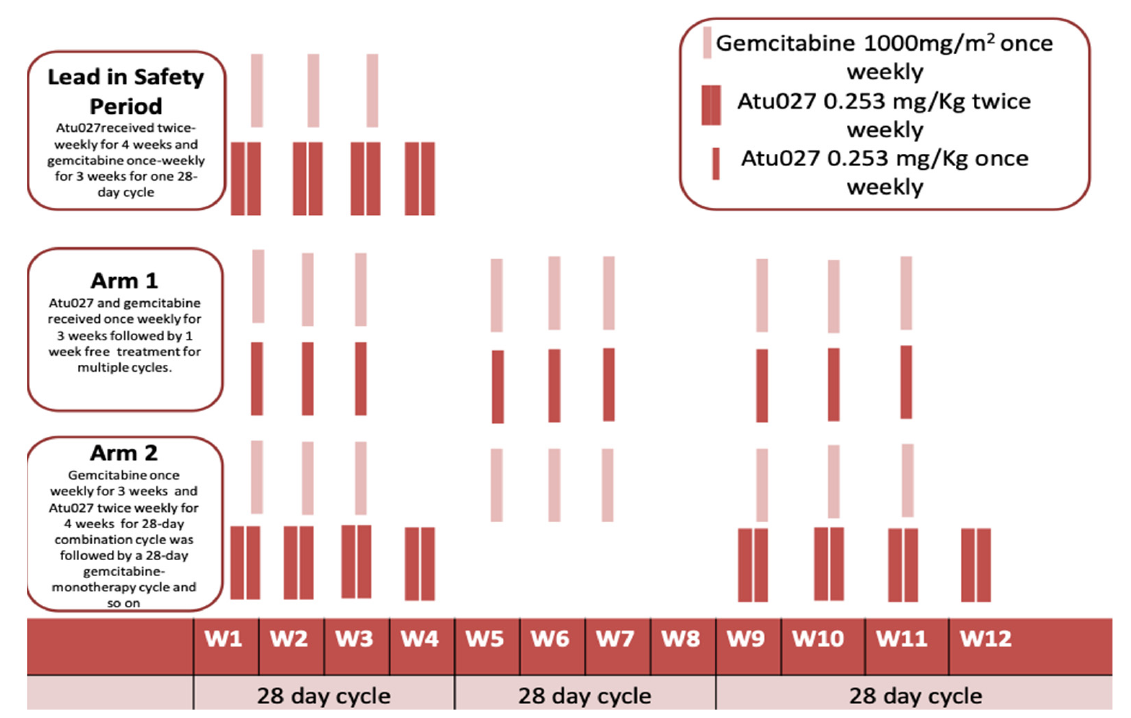
Figure 3. Dosage regimen in the safety cohort, arm 1 and arm 2 of phase Ib/IIa trial.